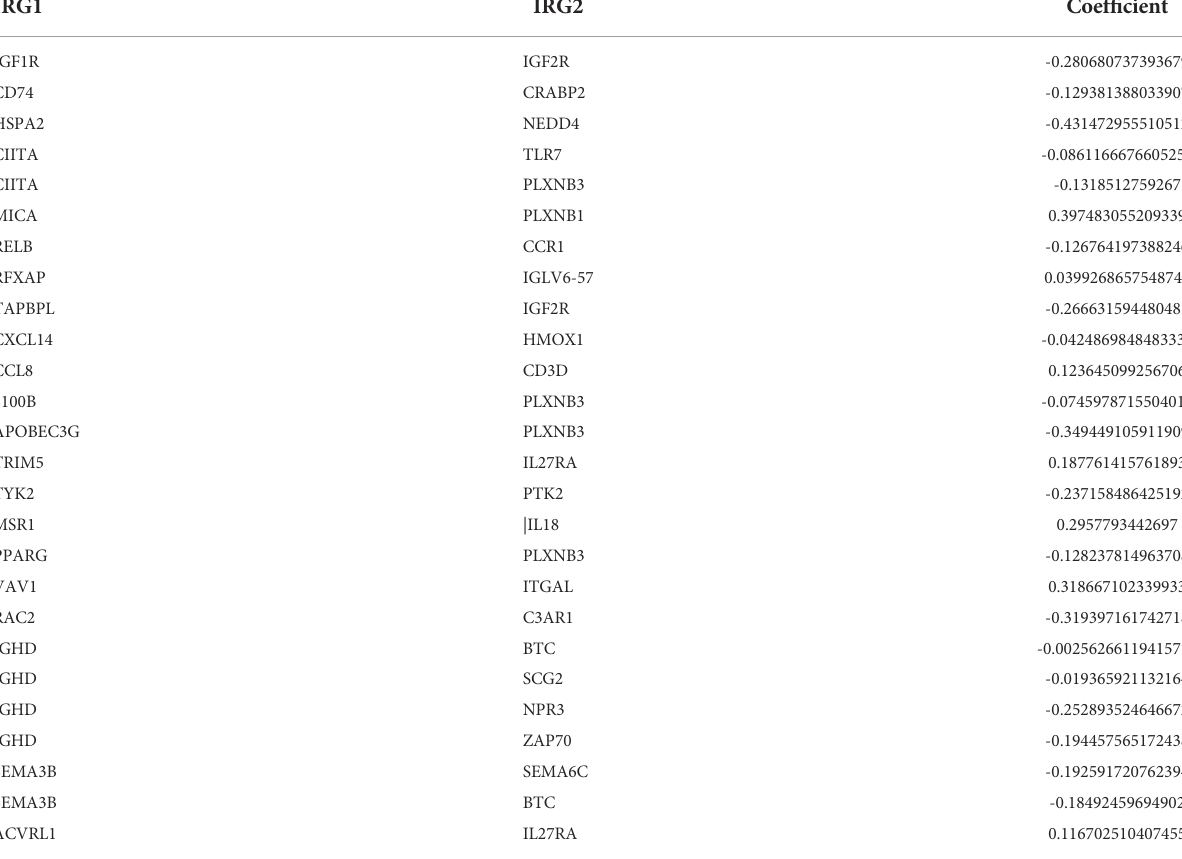
TABLE 1 Prognostic model based on immune-related gene